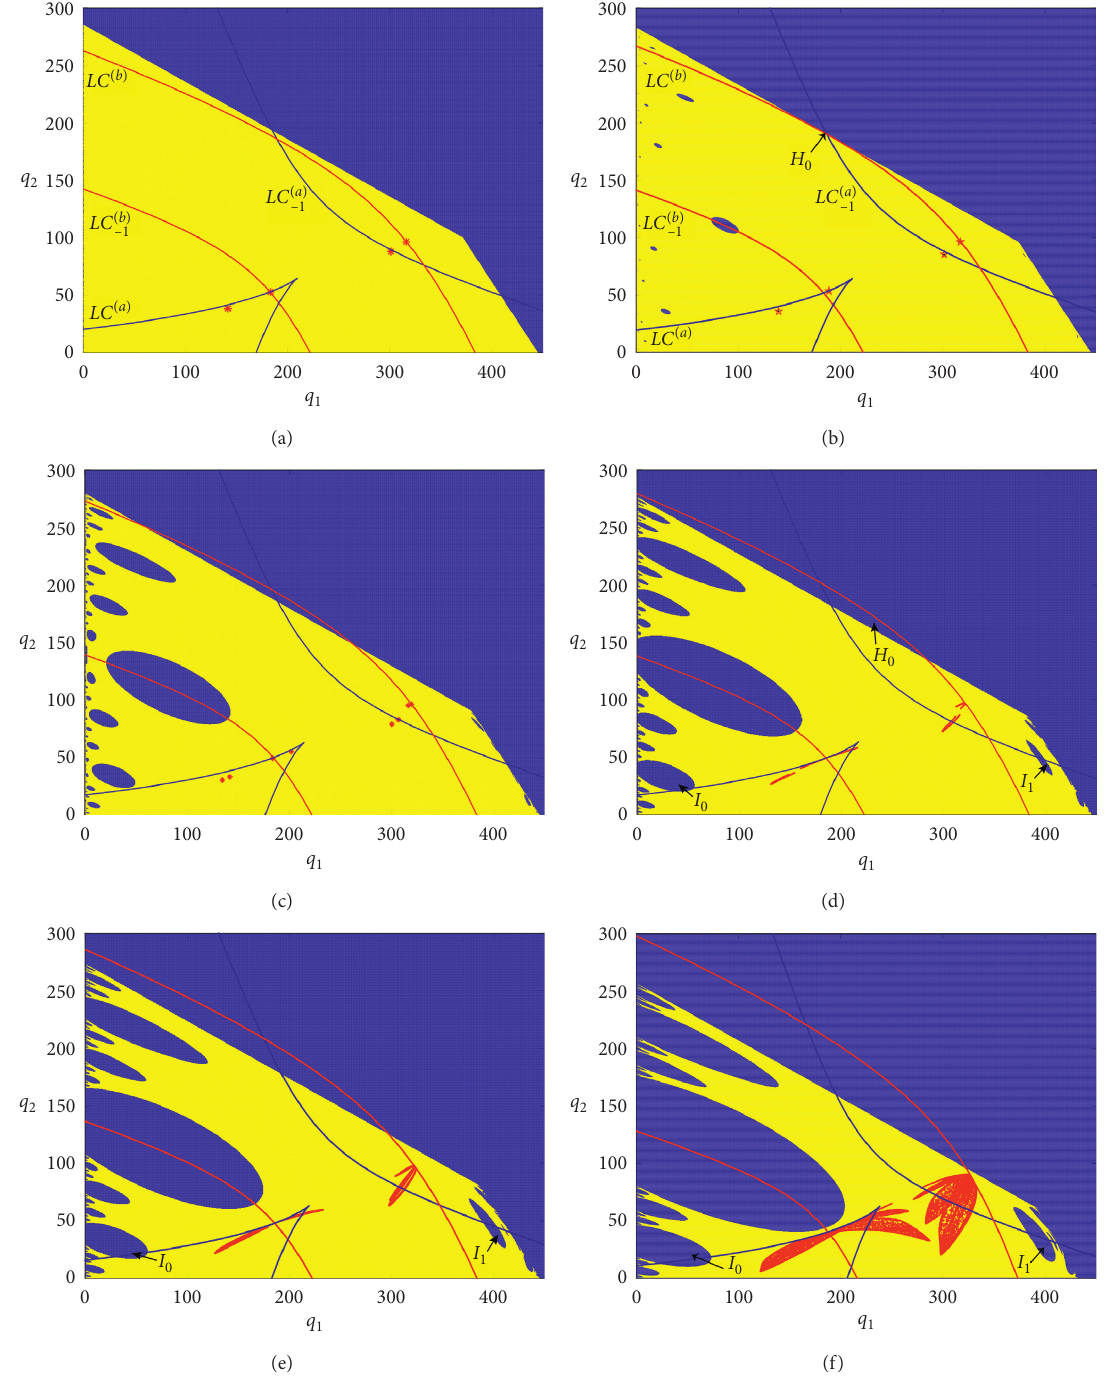
Figure 7: Various basins of attraction under parameters a − c � 0 . 586; (b) v (a) v 2